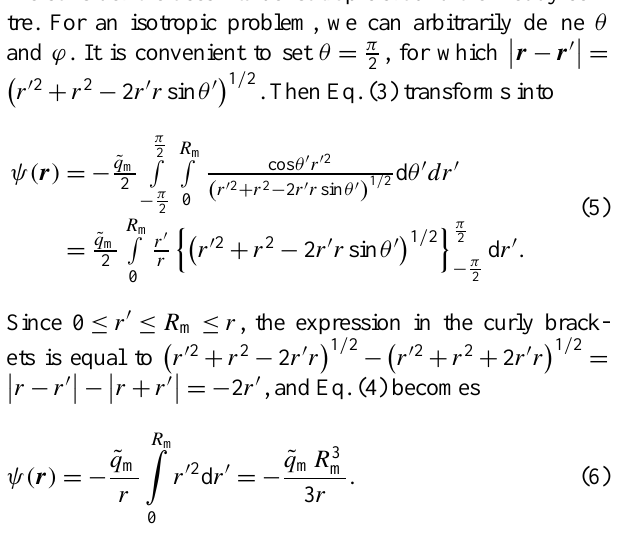
Table 3. Characteristics of the surface signals for a meddy with the R m = 30km and |˜ q m | = 0 . 7 f . In the northern subtropics